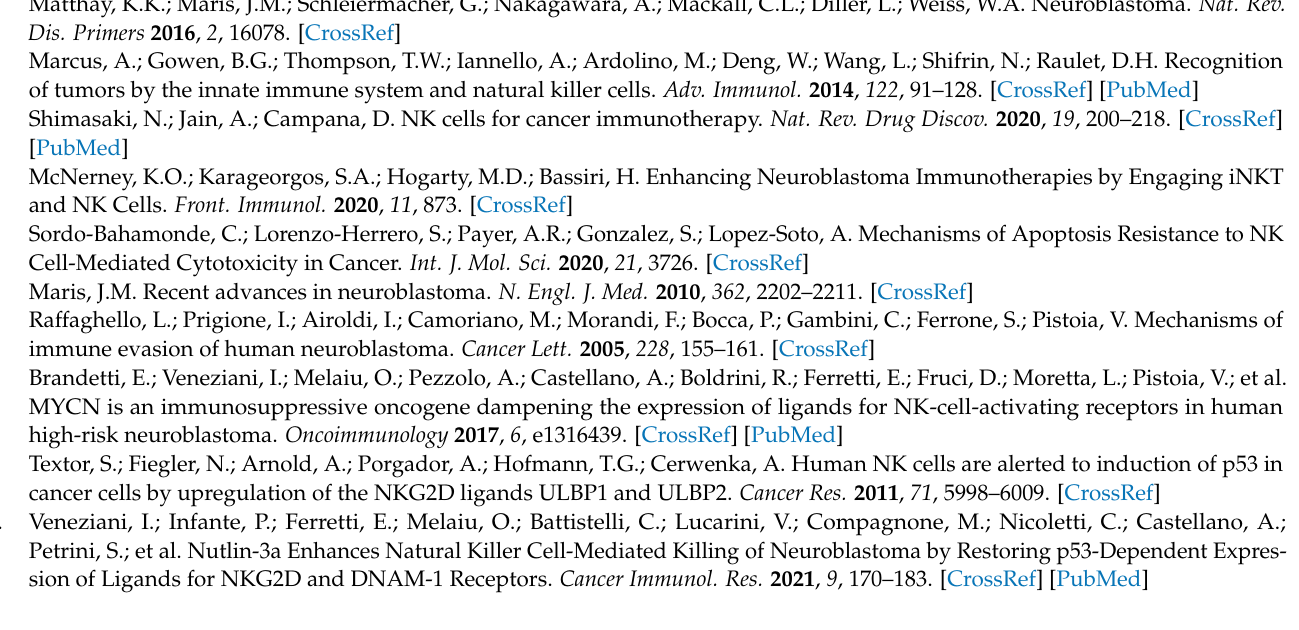
negative and a positive control for Figure 3D, Figure S5: Original western blots, Table S1: Status of the RELA gene in NB patients listed in Table 1, Table S2: Association between early and advanced stages of disease in NB patients with intact or loss of FAS and/or PVR